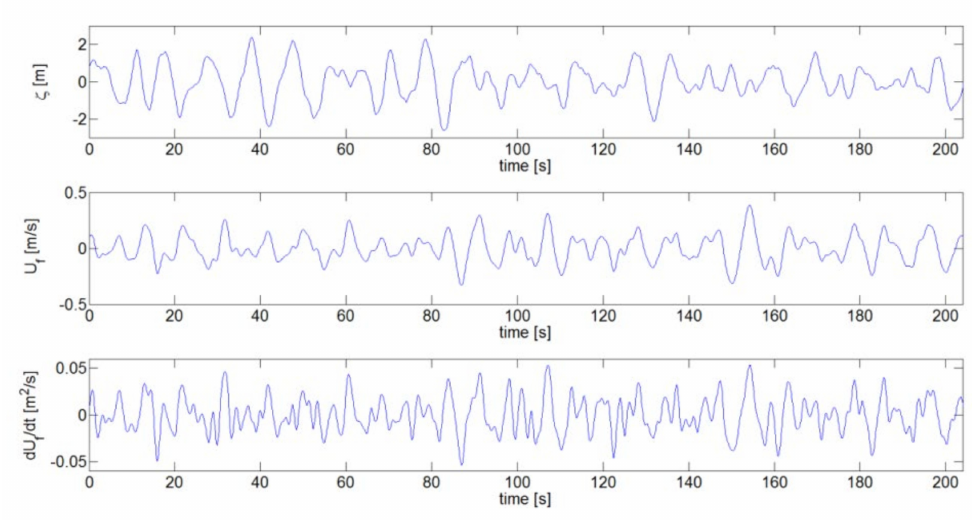
Figure 14. Numerically simulated water surface displacement, velocity, and acceleration at x = 19.0 m for H s = 5 m, and T p = 10 s.